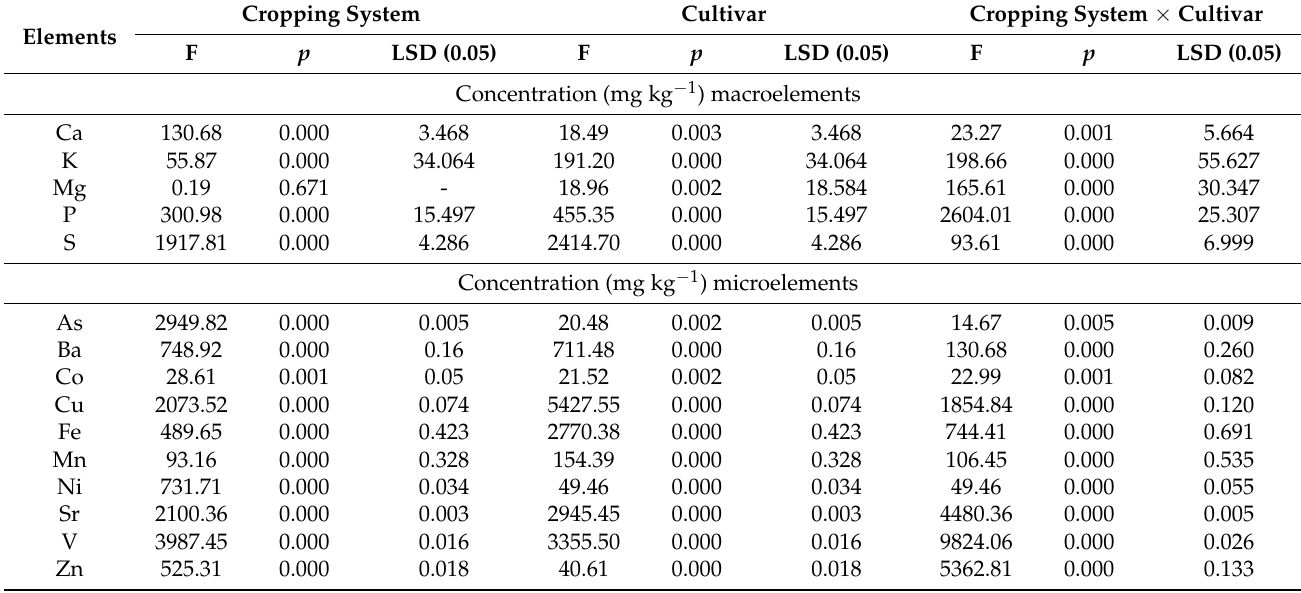
Table 3. Analysis of variance of the macro- and microelements concentration in the wheat grain in ICS and CCS cropping